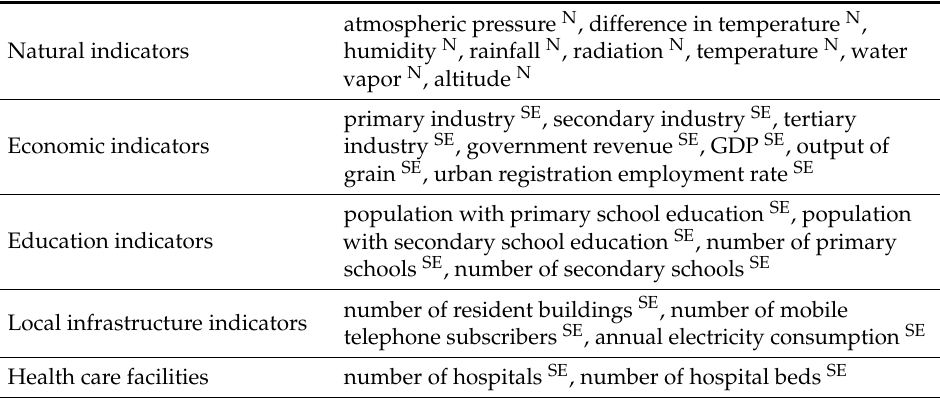
Table 2. Selected natural and socioeconomic